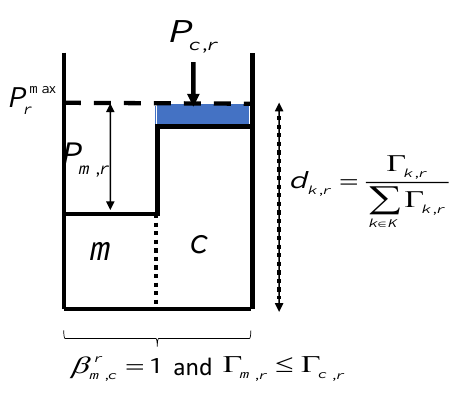
Figure 3. Non-orthogonal multiple access (NOMA) successive interference cancellation (SIC)-aware geometric water filling (GWF)